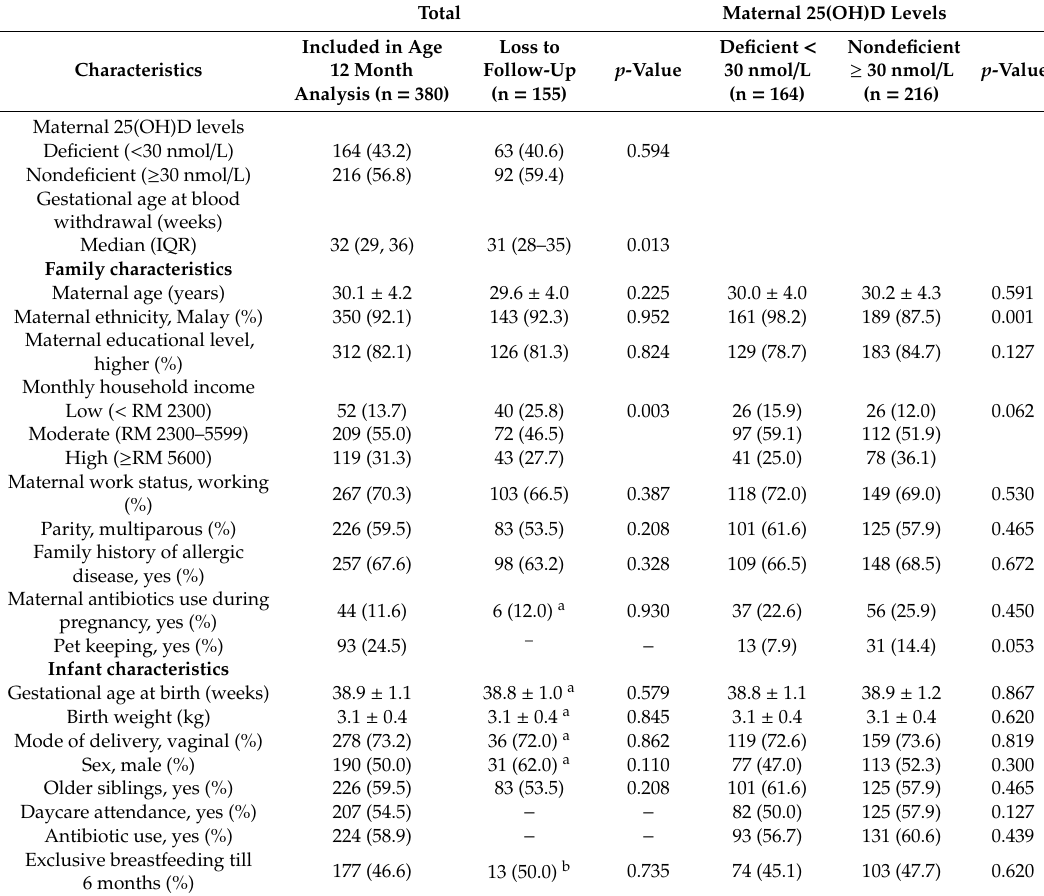
Table 1. Characteristics of the mother–child